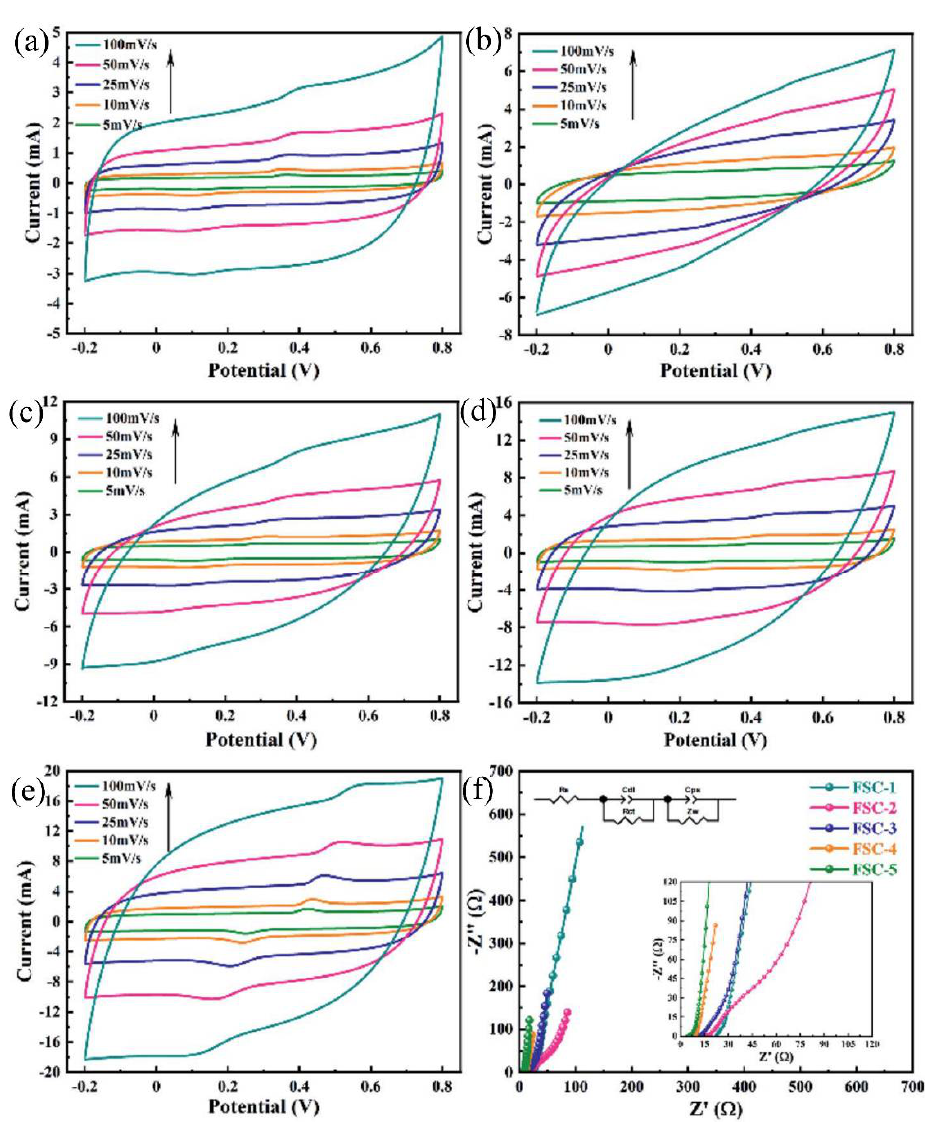
Figure 2. The CV behaviors of solid-state SCs at different scan rates: ( a ) FSC-1, ( b ) FSC-2, ( c ) FSC-3, ( d ) FSC-4, and ( e ) FSC-5. ( f ) Nyquist plots of the FSC devices (Reprinted from ref. [68]).